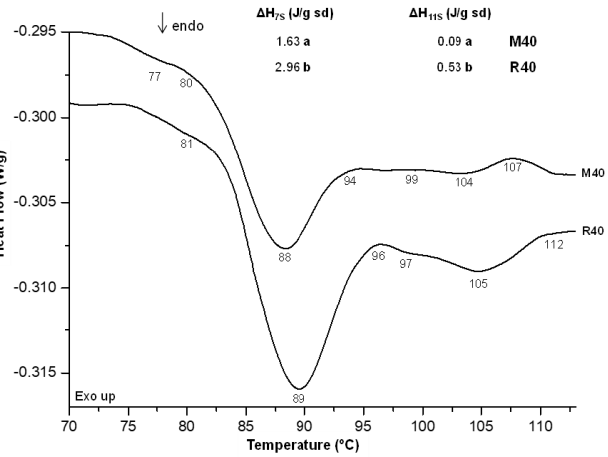
Figure 1. Differential scanning calorimetry thermograms of Misak and Rumbo lupine flour aque- ous suspensions. Different letters in the same parameters indicate a significant difference ( p <